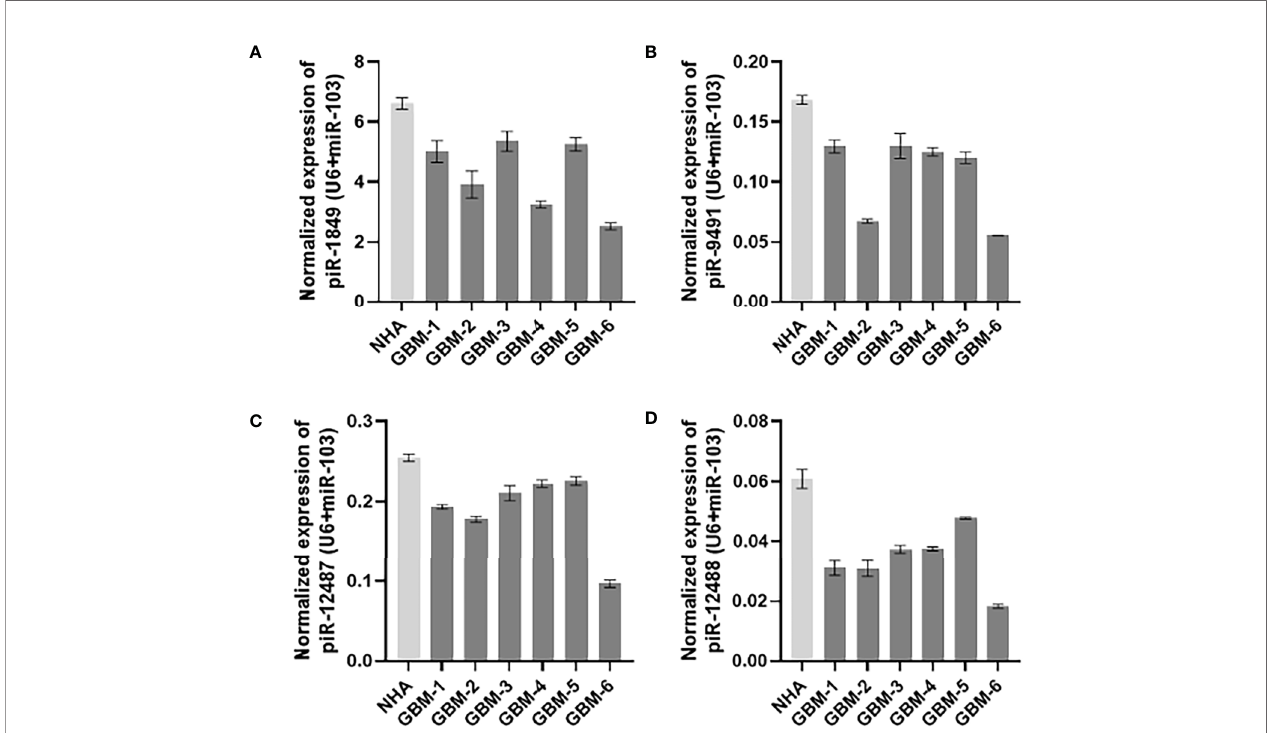
FIGURE 3 | Expression levels of (A) piR-1849; (B) piR-9491; (C) piR-12487; (D) piR-12488 in normal human astrocytes (NHA) and primary glioblastoma cell lines analyzed by